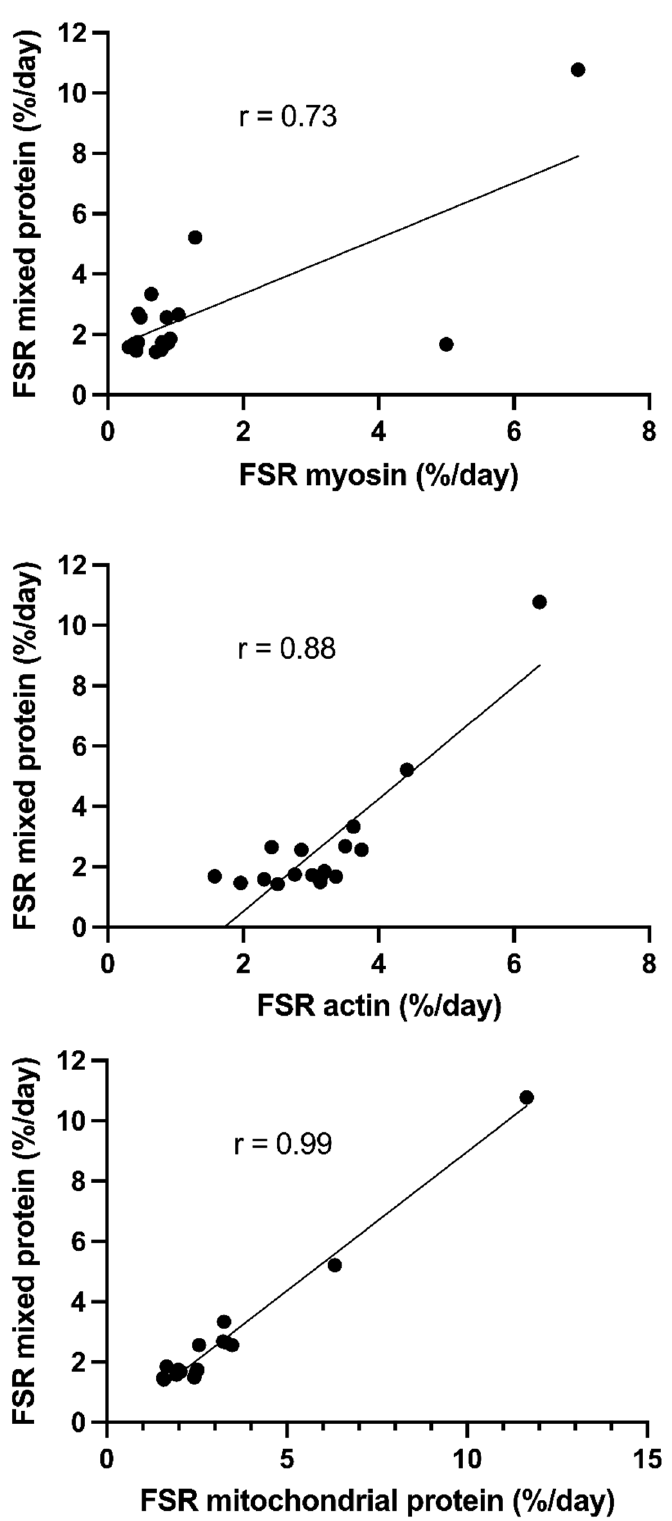
Figure 4. Correlation between means in the fractional synthesis rates (FSRs) of skeletal muscle mixed protein and FSRs of 3 protein fractions (top: myosin; middle: actin; bottom: mitochondrial protein) ( n = 17) using regression analysis. The mitochondrial FSRs have been previously published [15].